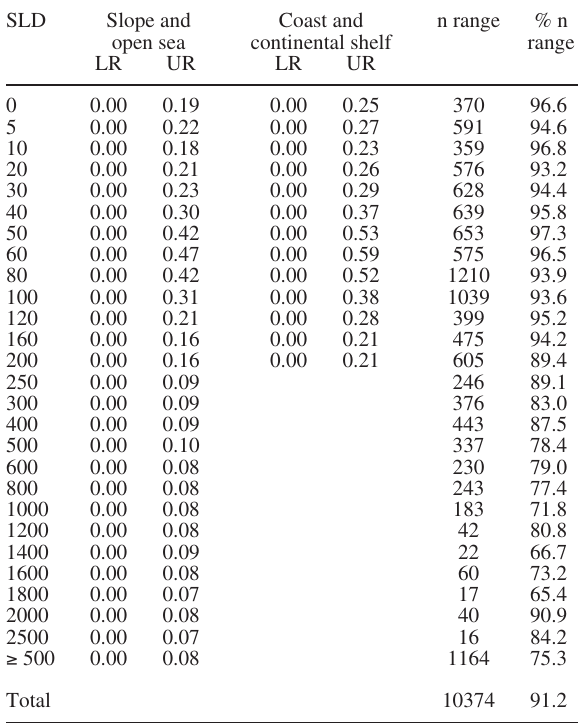
Table 9. – Nitrate concentration ( m M) ranges in the NW Mediter- Table 10. – Nitrite concentration ( m M) ranges in the NW Mediter- ranean Sea in mixed water columns (stratification coefficient = 1). ranean Sea in stratified water columns (stratification coefficient = 2, Headers as in Table 7. 3 and 4). Headers as in Table 7.